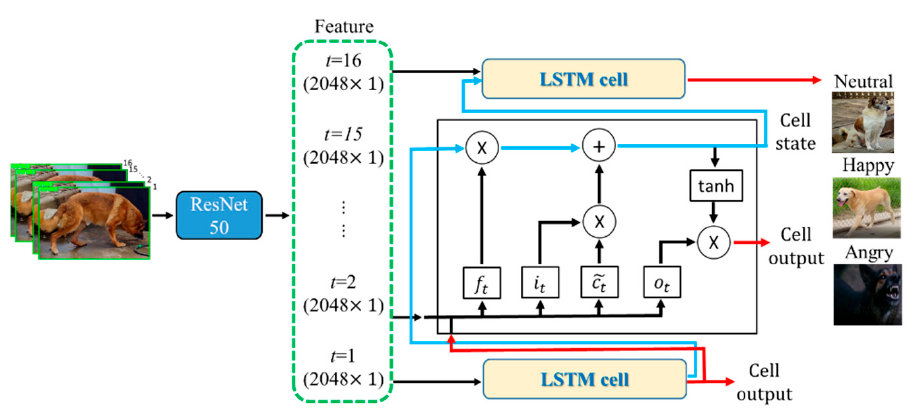
Figure 8. LDFDMN model.